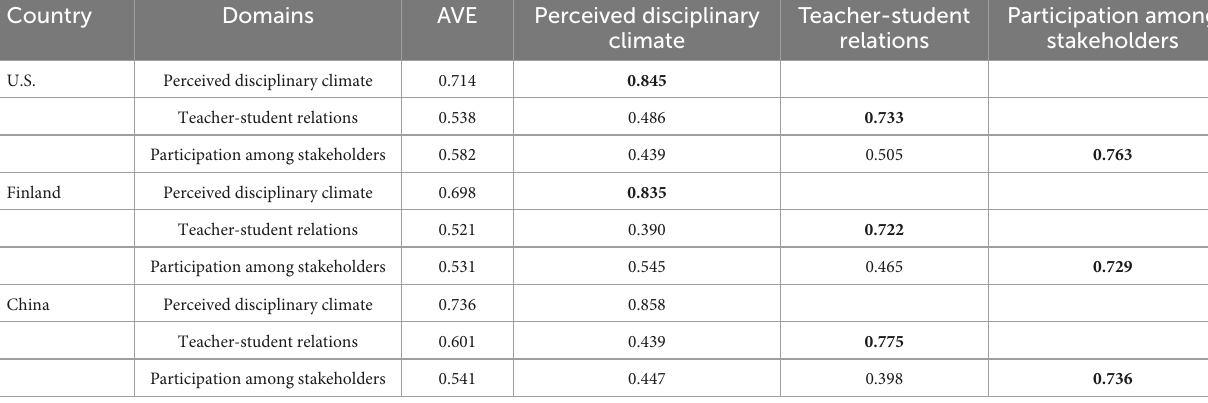
TABLE 4 Discriminant validity of school-climate measures.